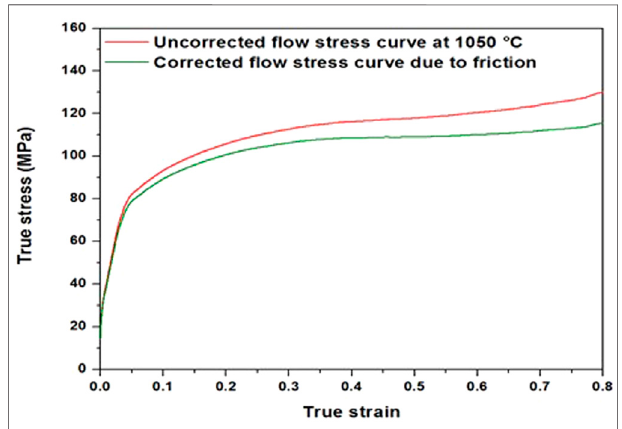
FIGURE 4 | Effect of the application of the average friction coef fi cient model. The curve showing lower stress is the friction-corrected curve, whereas the curve showing higher stress is the experimental row